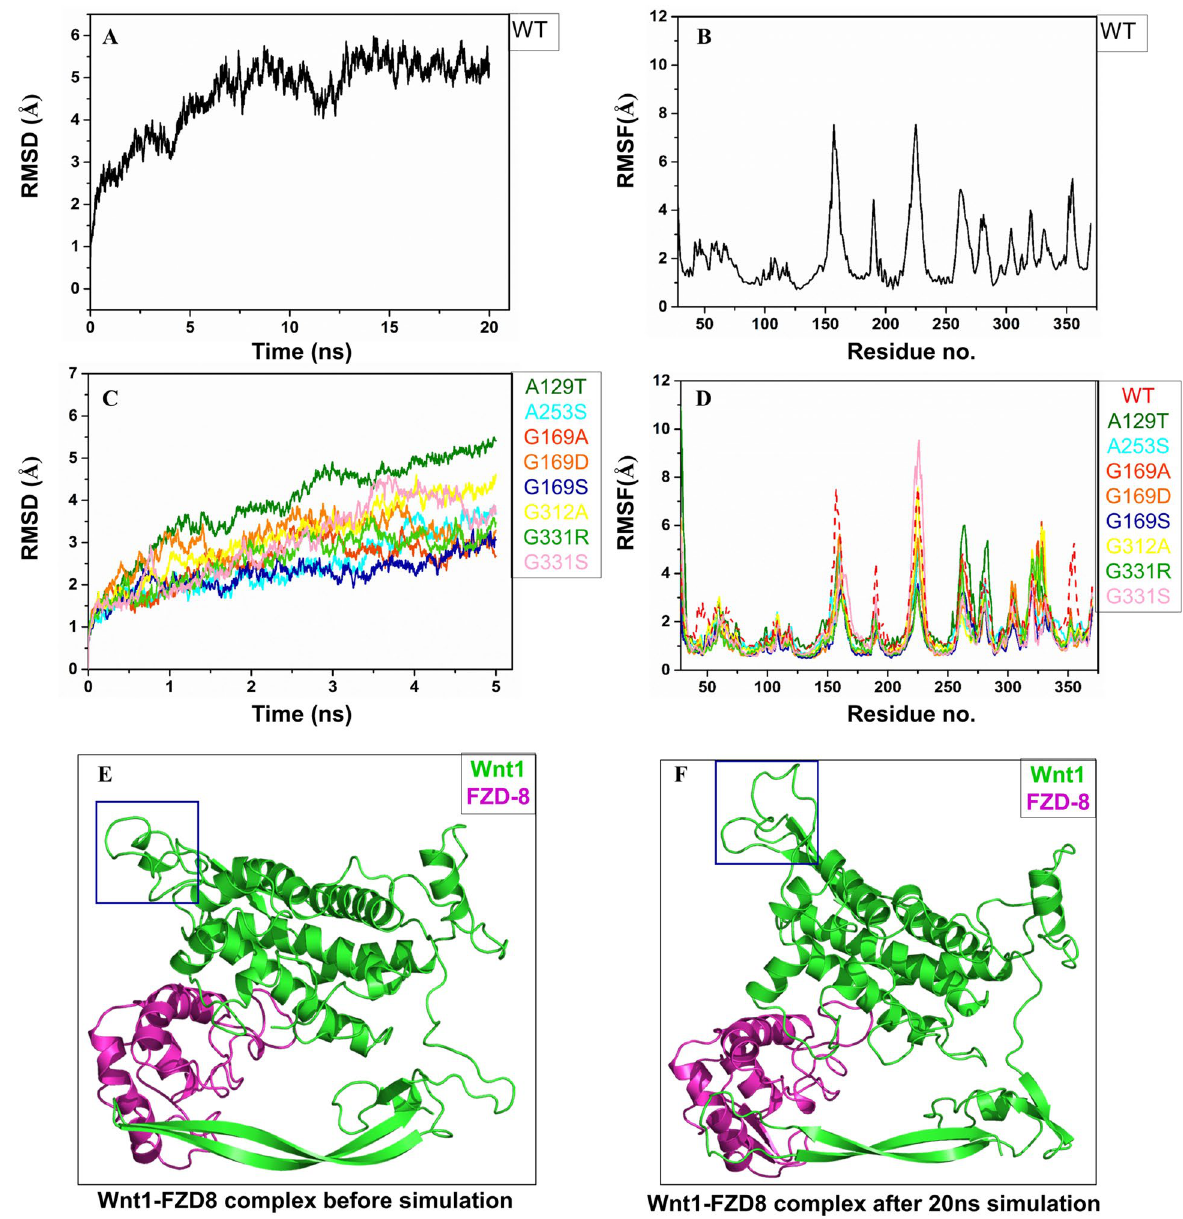
Figure 4. RMSD of Cα atoms of Wnt1 in ( A ) WT and ( C) Mutated forms in complex states. RMSF of Cα atoms of Wnt1 in ( B ) WT and ( D ) Mutated forms in complex states. ( E ) Modelled structure of Wnt1 before the MD simulation. ( F ) Structure of Wnt1 after the 20 ns MD simulation. Residues 225–245 showing reorientation before and after the MD simulations (marked in blue box) ( E , F